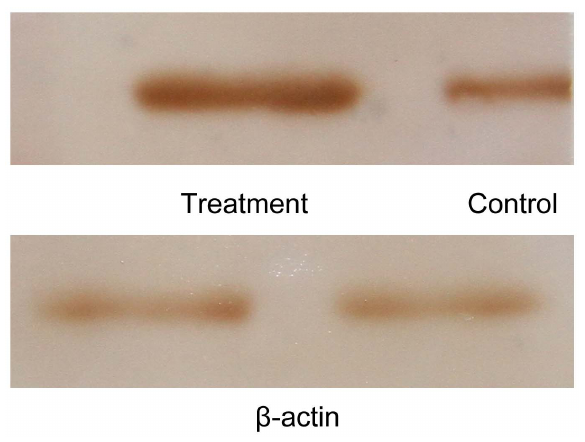
Figure 5. Western blot analysis of expression of Px Serpin 2. Note: Those were visualized by DAB. Actin was used as an internal control.